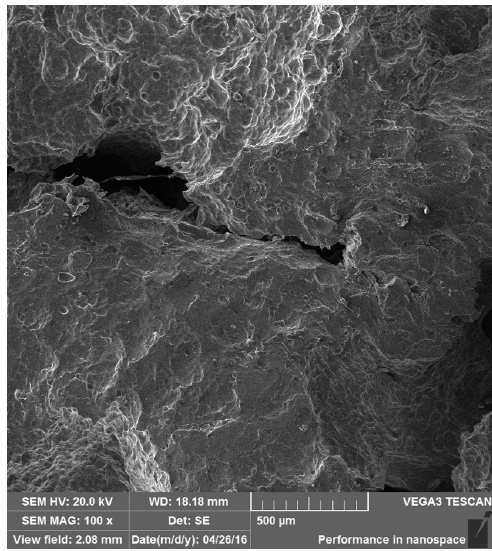
Figure 11. Failure of Ni/Al hybrid foams at room temperature: ( a ) 100× and ( b ) 1000×.